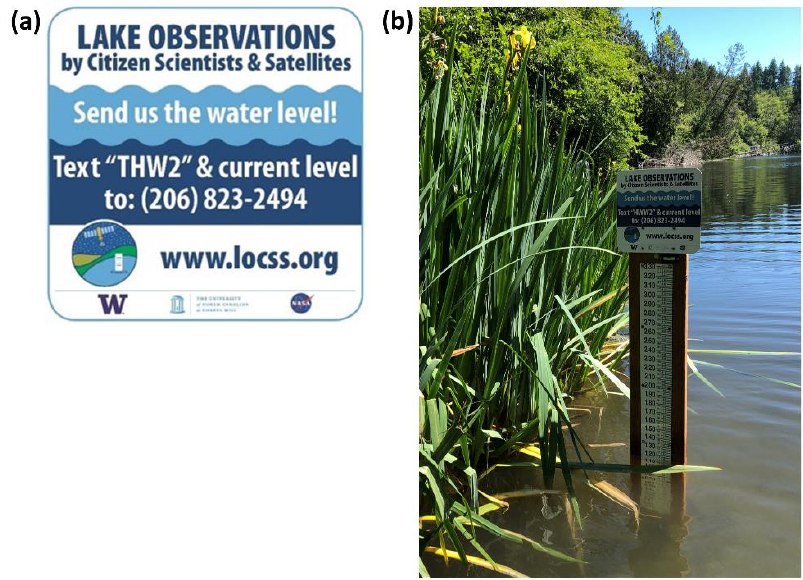
Figure 2. An example of a LOCSS lake gauge with a sign on top for texting in measurements. Figure ( a ) depicts a LOCSS lake gauge sign and what a citizen scientist would read. Figure ( b ) depicts a LOCSS lake gauge located in Lake Howard, WA.